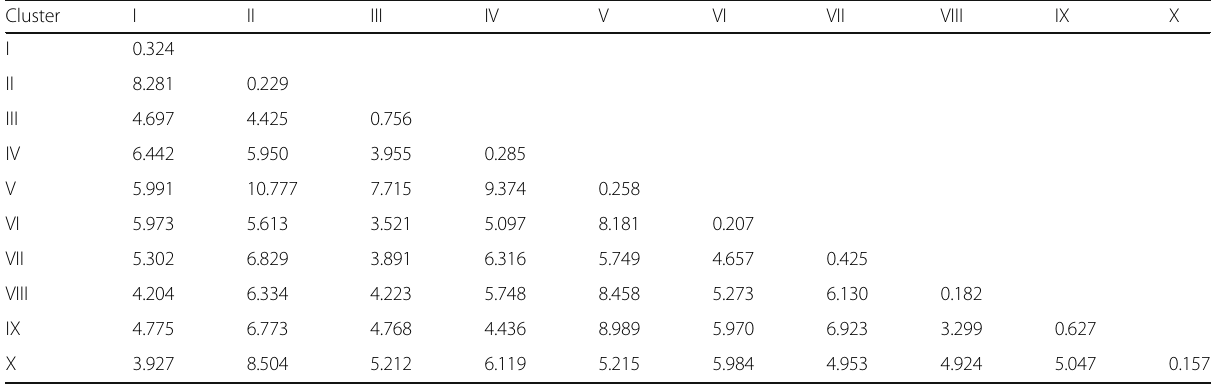
Table 3 Average intra and inter cluster distances ( D 2 ) values for 100 cotton genotypes